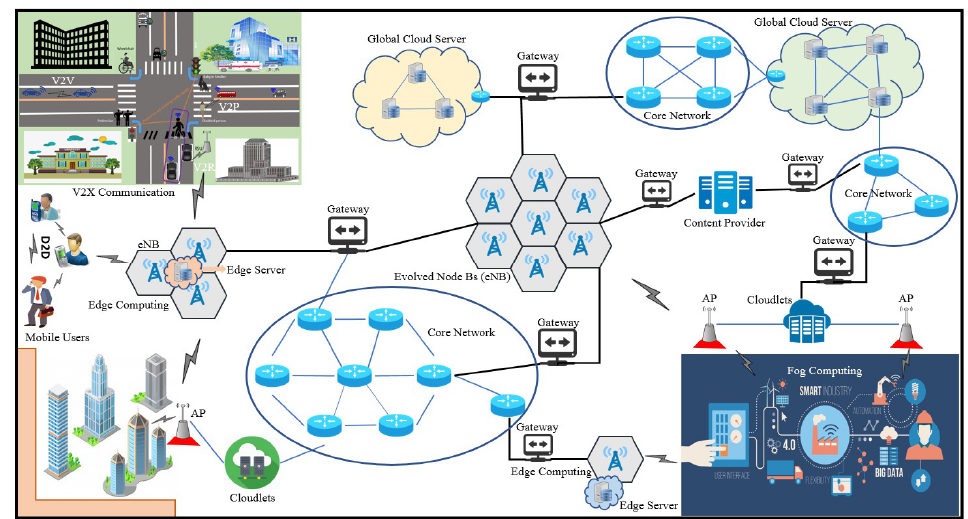
Figure 3. An overall view of our proposed architecture.